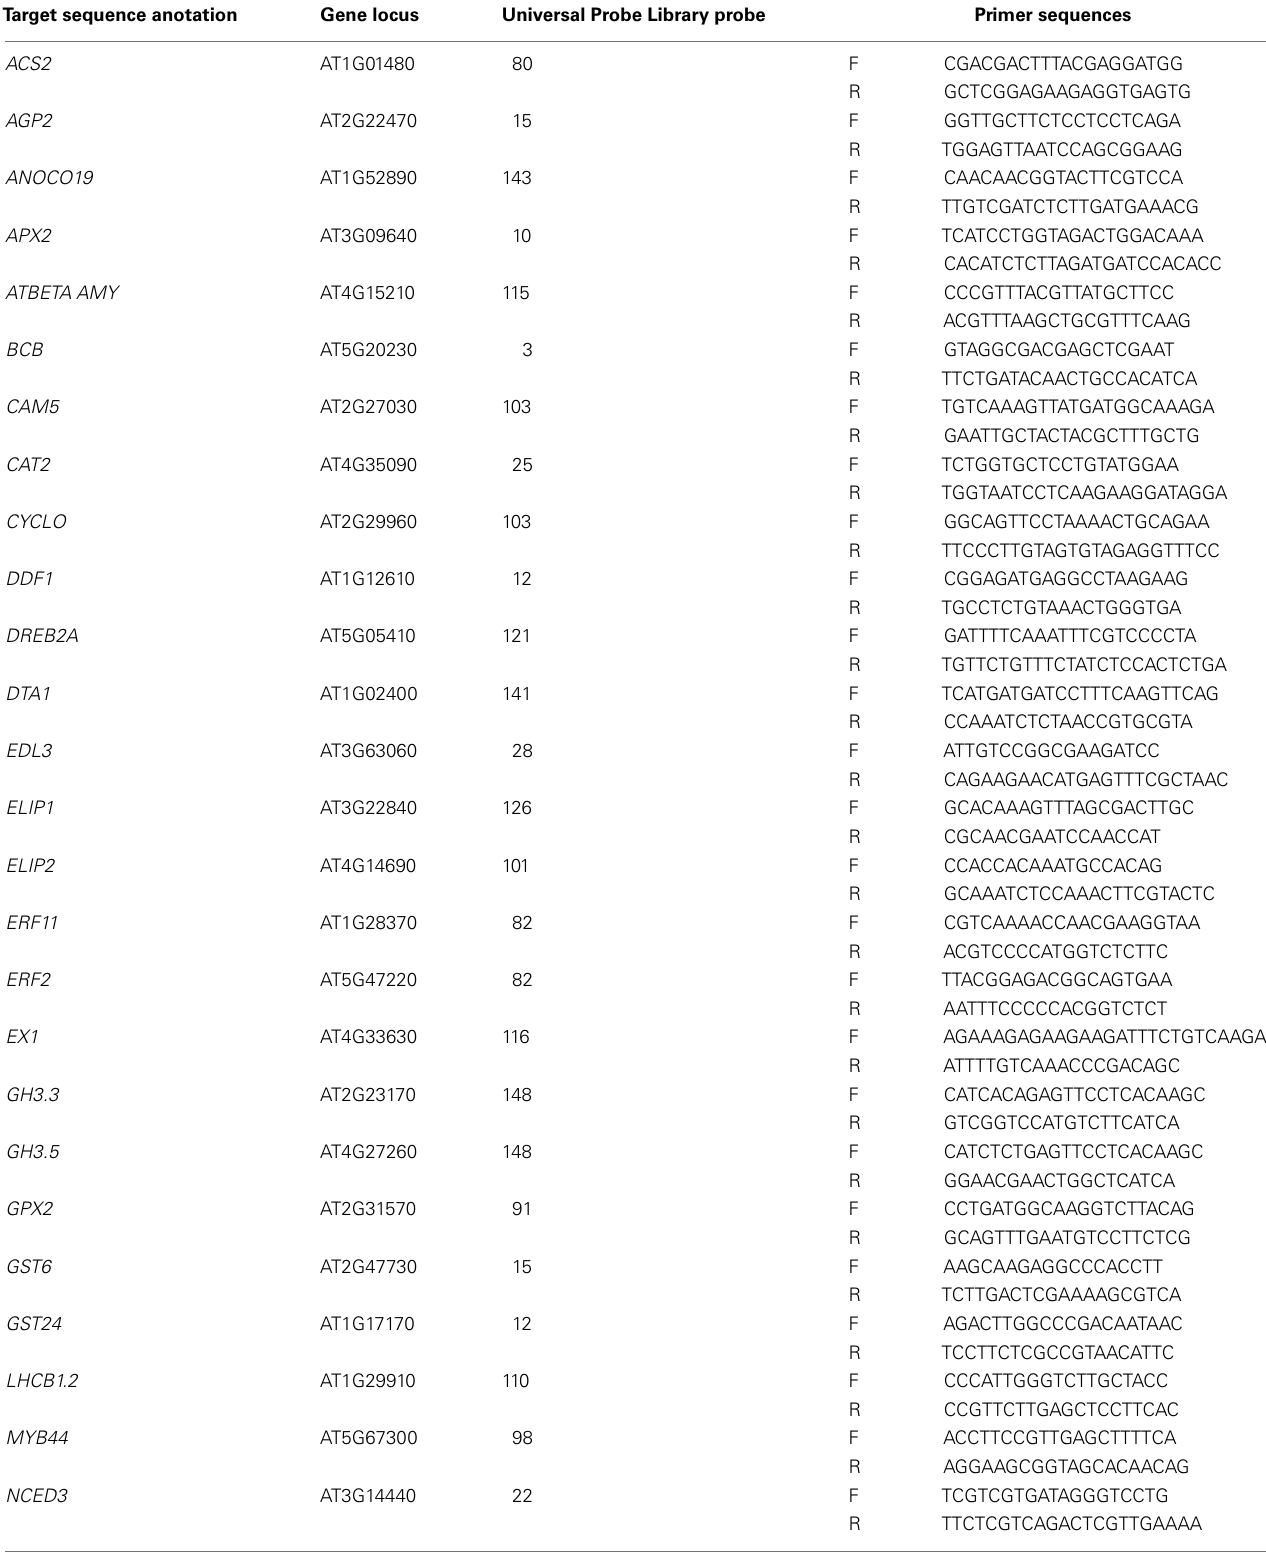
Table 2 | Real-time RT-PCR primers and Universal ProbeLibrary probes (Roche) used for quantitative transcript